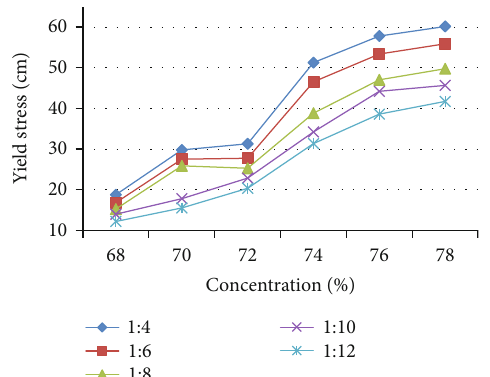
Figure 5: Relationship curve between yield stress and concentration of mixed slurry with di ff erent cement tailing ratios.